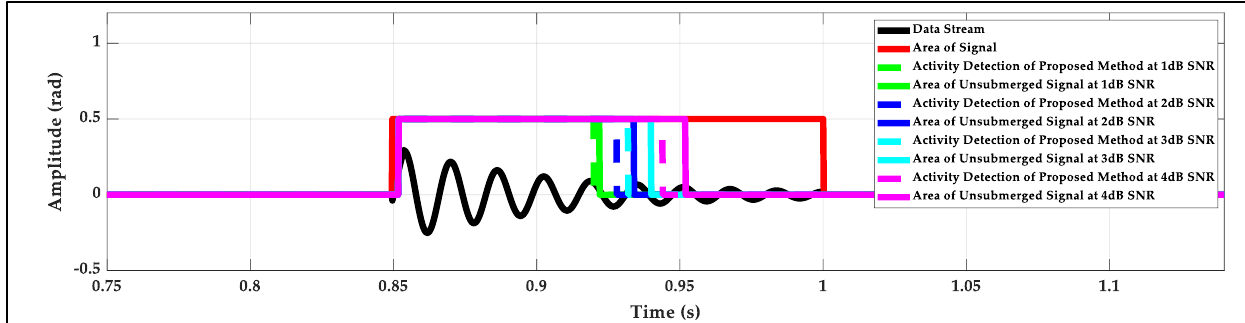
Figure 12. The detected endpoint errors of the proposed method at 1 to 4 dB SNR.